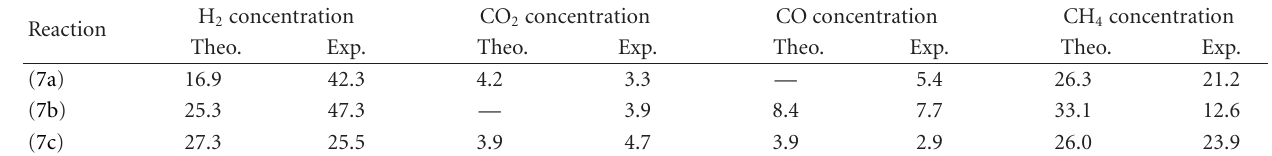
Table 2: Steady-state concentration (%) of the reactants and products of methanation process. H 2 concentration CO 2 concentration CO concentration CH 4 concentration Reaction Theo. Exp. Theo. Exp. Theo. Exp. Theo.